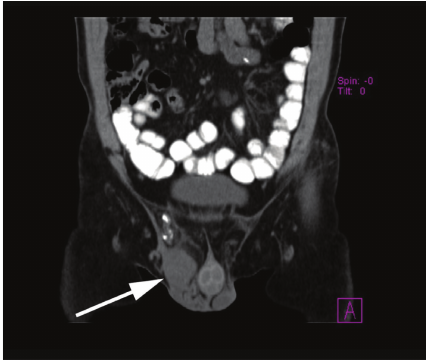
Figure 2: CT scan showing a solid soft-tissue mass of 3.6 × 3.7 × 5.8 cm in the right scrotum (white arrow).